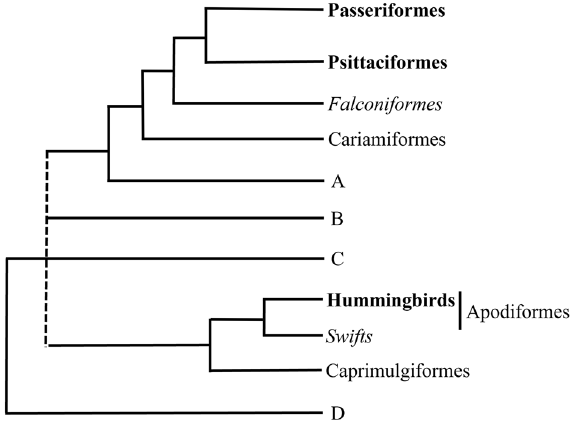
Figure 1. Avian phylogeny (adapted from Hackett et al. 7 and Braun and Kimball 8 ). Clades of vocal learners are in bold, sister taxa to learners are italicized, all other orders are in roman text. Clades B, C and the Apodiformes are in an unresolved relationship with the Passeriformes clade. D includes the Galliformes and Anseriformes, sister taxa to all of the others in this phylogeny. See Hackett et al. (2008) for clades included in A, B, C,